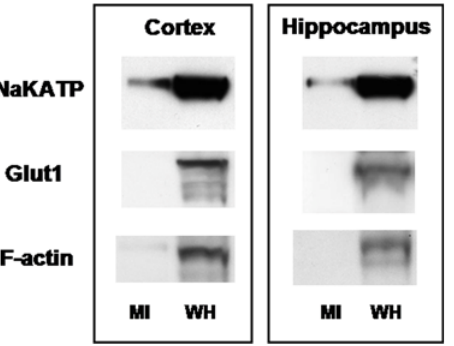
Figure 10. Immunoblots of mitochondrial fractions (MI) from primary neuronal cultures developed from rat cortex and hippocampus. Whole homogenates (WH) of the same cells were loaded as positive controls. Mitochondria were immunoblotted using plasma membrane markers for b 1 -Na + -K + -ATPase and GLUT1 as well as the cytosol marker F-actin. Mitochondrial fractions (MI) showed the presence of b 1 -Na + -K + -ATPase. However, while prominent in whole cell homogenates (WH), the other plasma membrane marker Glut1 and the cytosol marker F-actin were not apparent.